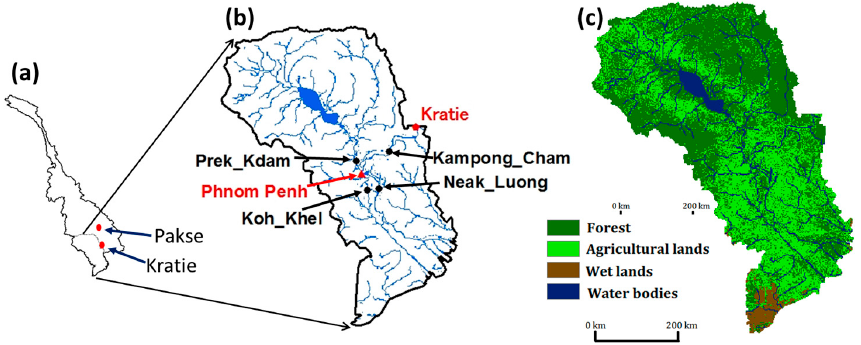
Figure 1. Study area and river gauging stations ( a ) Mekong River Basin (BTOP model domain) , ( b )LMB area (RRI model domain), and ( c ) LMB land use map used in RRI model.